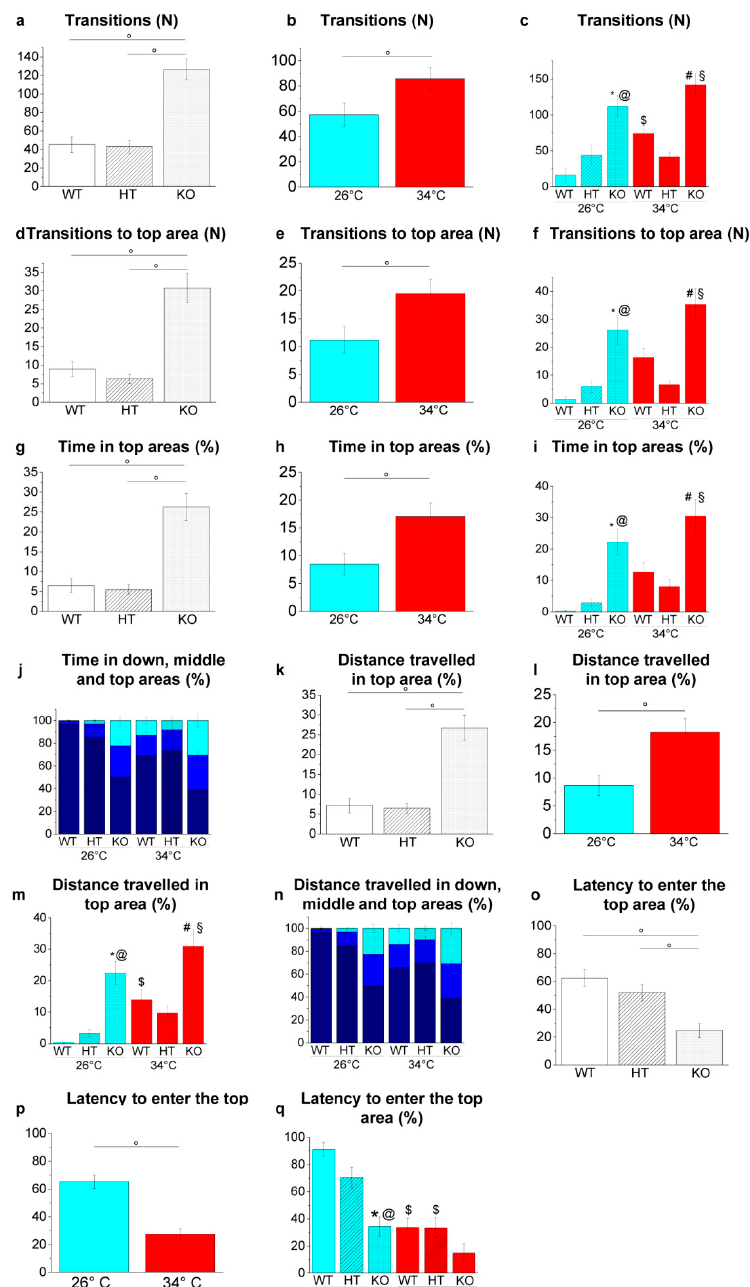
Figure 10. Novel environment exploration behaviour in the NTT. ( a – c ) Transitions among areas; ( d – f ) transitions to top area; ( g – i ) time spent in the top area expressed as a percentage of the total time; ( j ) time spent in the three vertical virtual areas of the tank expressed as a percentage of the total time; ( k – m ) distance travelled in the top area expressed as a percentage of the total distance travelled, ( n ) distance travelled in the three vertical virtual areas of the tank expressed as a percentage of the total distance travelled; ( o – q ) latency to enter the top area. The data are expressed as means ± S.E.M. and analysed by two-way ANOVA with Bonferroni post hoc correction. p ≤ 0.05, ◦ ; *, HT26 vs. WT26 or KO26 vs. WT26; @, KO26 vs. HT26; #, HT34 vs. WT34 or KO34 vs. WT34; §, KO34 vs. HT34; $, WT34 vs. WT26, HT34 vs. HT26 or KO34 vs. KO26. p values and symbols used in the figure are shown in Table S23. N = 20. In panels J and N, dark blue, blue and light blue colours refer respectively to bottom, middle and top areas of the tank. In all other panels, blue and red colours refer to 26 ◦ C and 34 ◦ C,